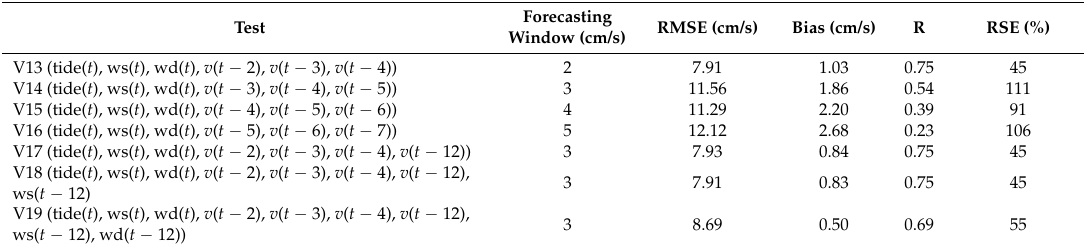
Table 9. Averaged statistics of v velocity component at ten locations (testing